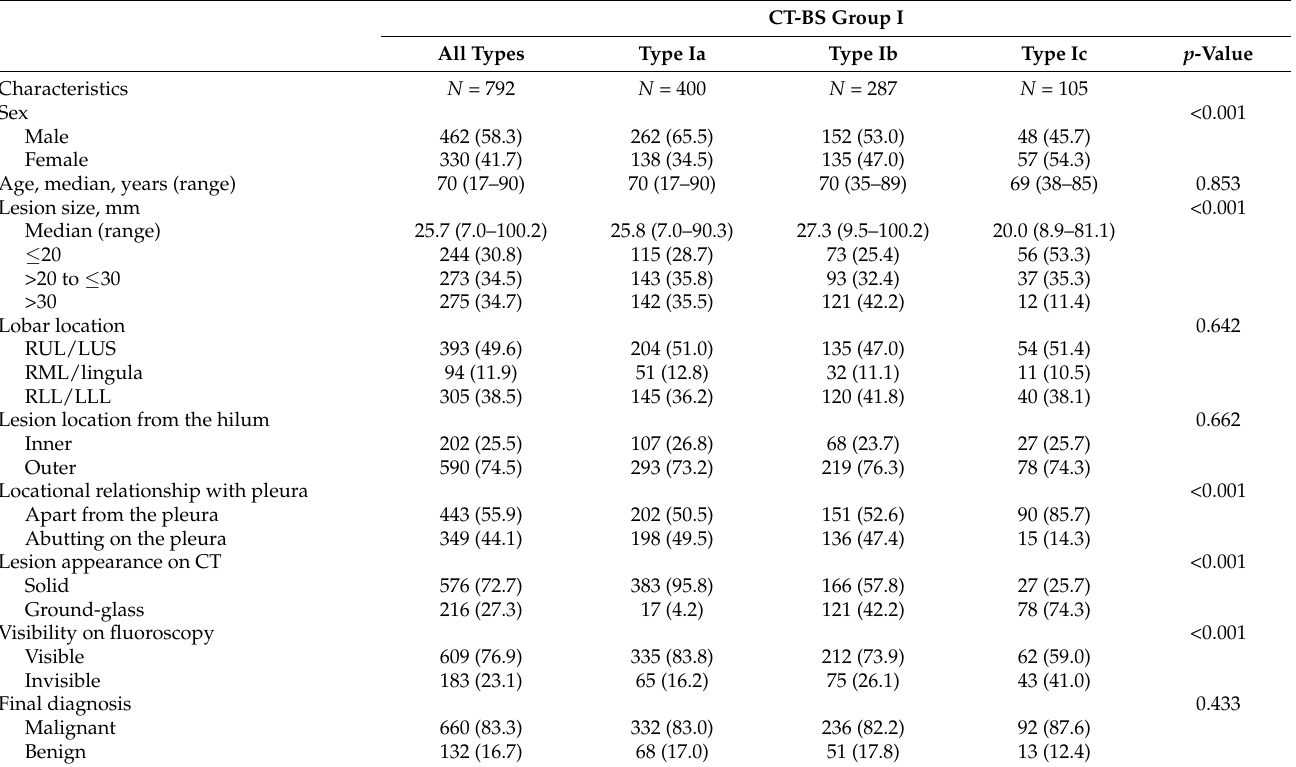
Figure 2. Study cohort flowchart. rEBUS-TBB, radial endobronchial ultrasound guided transbronchial biopsy; CT, computed tomography; CT-BS, CT bronchus sign. Table 1. Characteristics of patients and lesions in CT- group I.